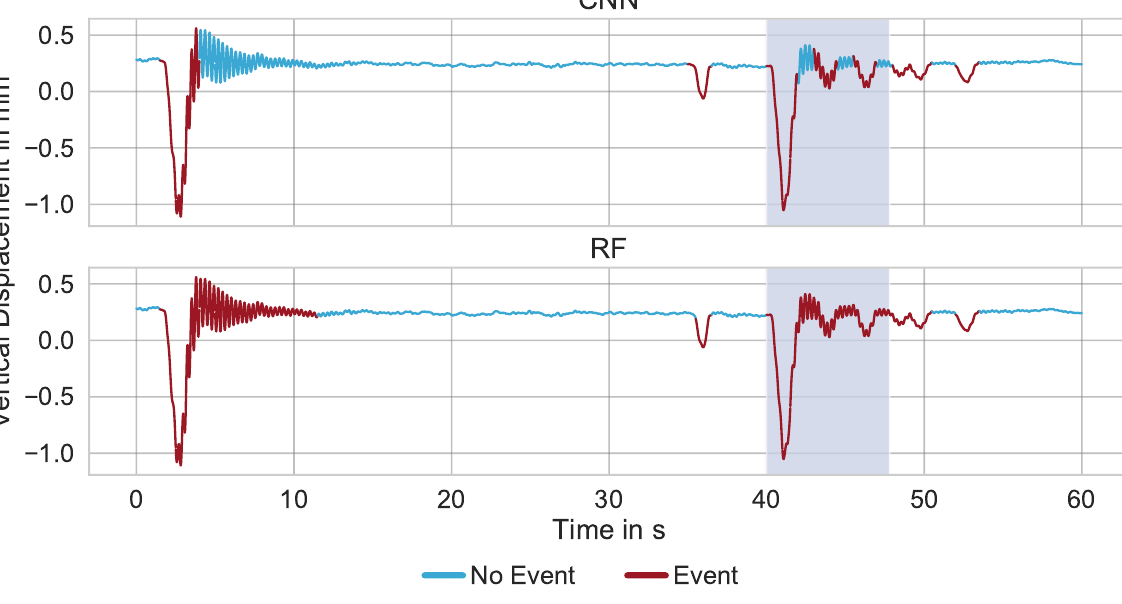
Figure 4. Confusion matrices of the CNN model (left) and the RF model (right) for (a) dataset I and (b) dataset II. &11